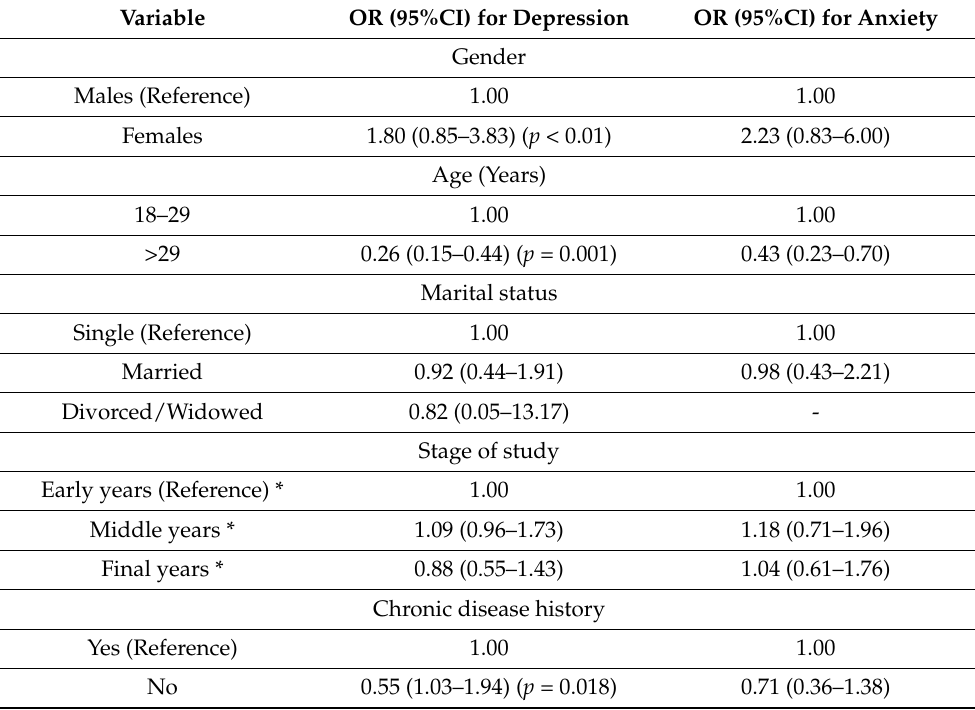
Table 5. Logistic regression analysis for undergraduate students in the health sciences center